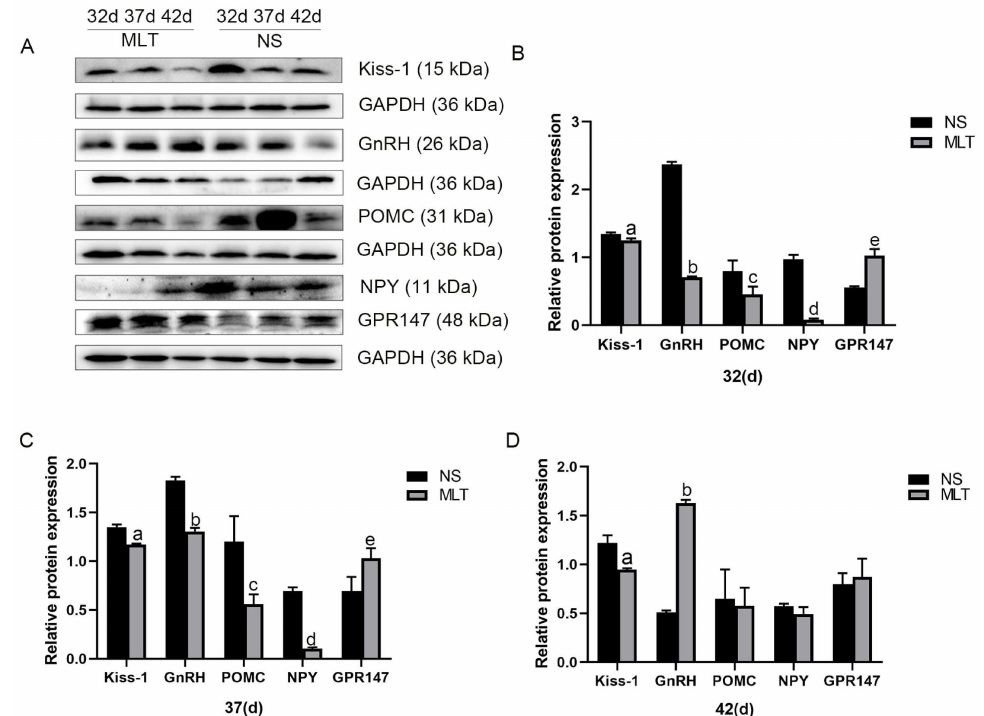
Figure 6. Melatonin’s effects on the expression of neuronal proteins associated to reproduction in the mice’s hypothalamus and its potential mode of action (n = 13). ( A ) Protein expression levels of Kiss-1, GnRH, POMC, NPY and GPR147 after subcutaneous injection of melatonin were detected via western blot analysis. ( B ) At 32 days old. ( C ) At 37 days old. ( D ) At 42 days old. a, b, c, d, e: p < 0.05 vs. the NS group. 32 d, 32 days; 37 d, 37 days; 42 d, 42 days; NS, normal saline; MLT,